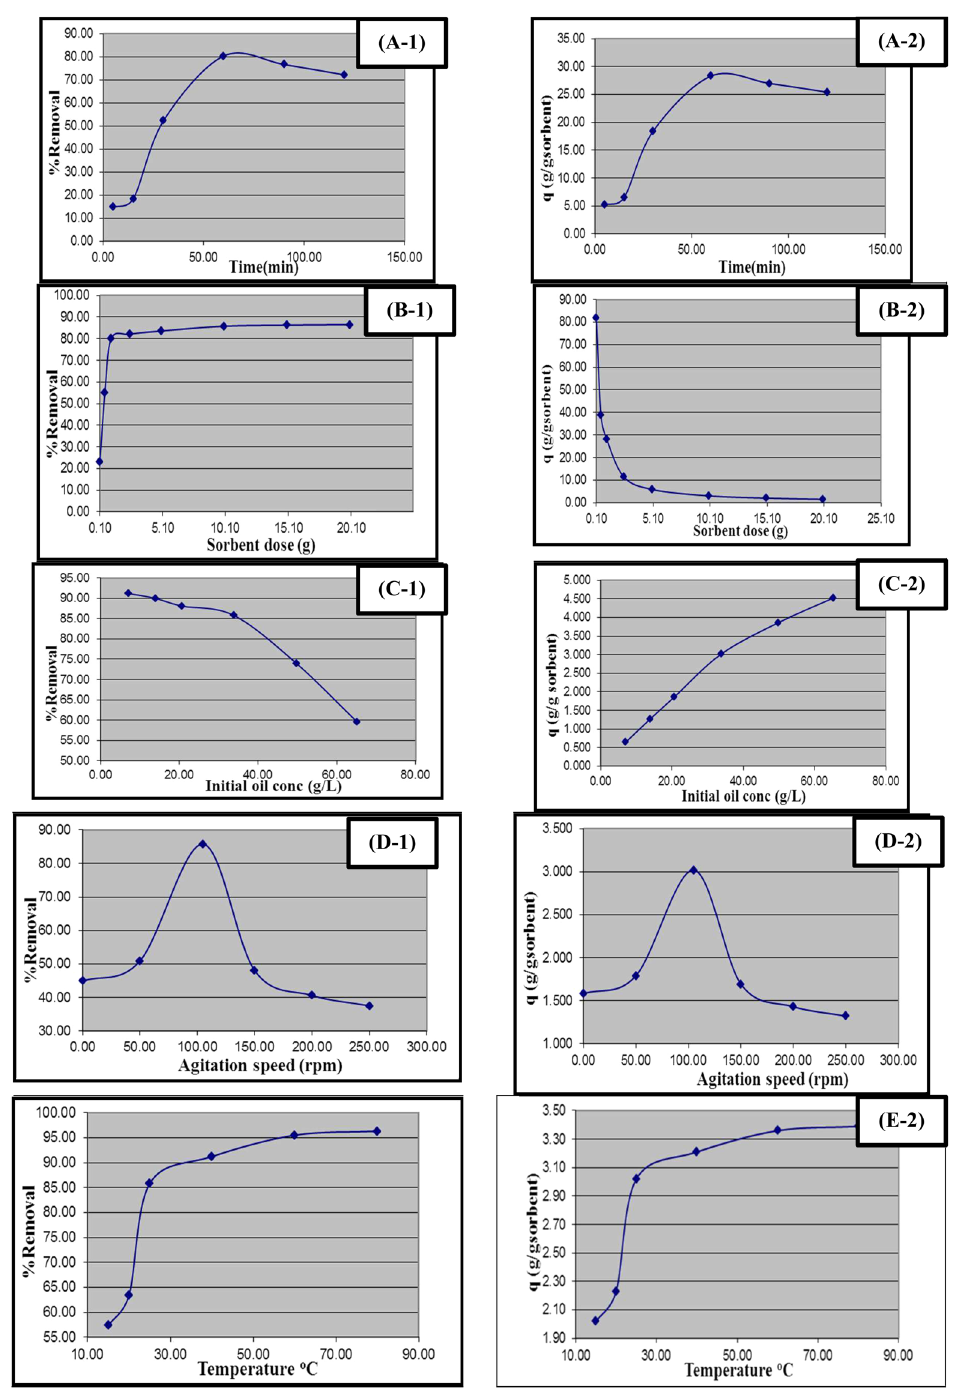
Figure 7. Influence of oil spill removal processing parameters onto both percentage oil removal and oil adsorption capacity using nano-magnetic activated carbon material: (A) sorption time, (B) sorption dosage, ( c ) initial oil concentration, ( d ) agitation speed, ( e )